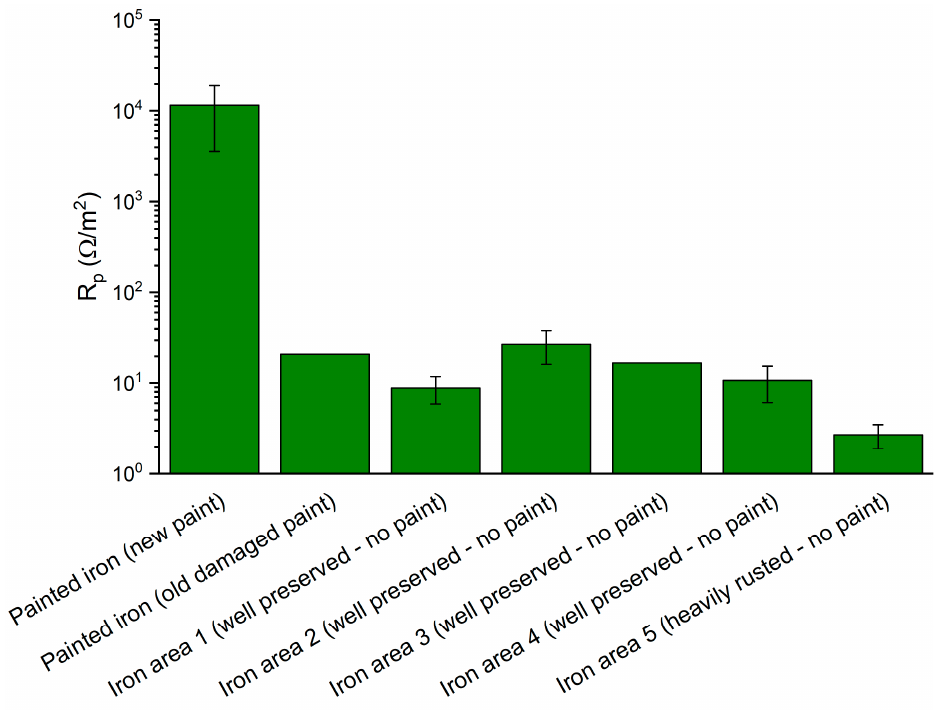
Figure 13. In situ polarization resistance measurements on iron elements of the San Carlone of Arona.